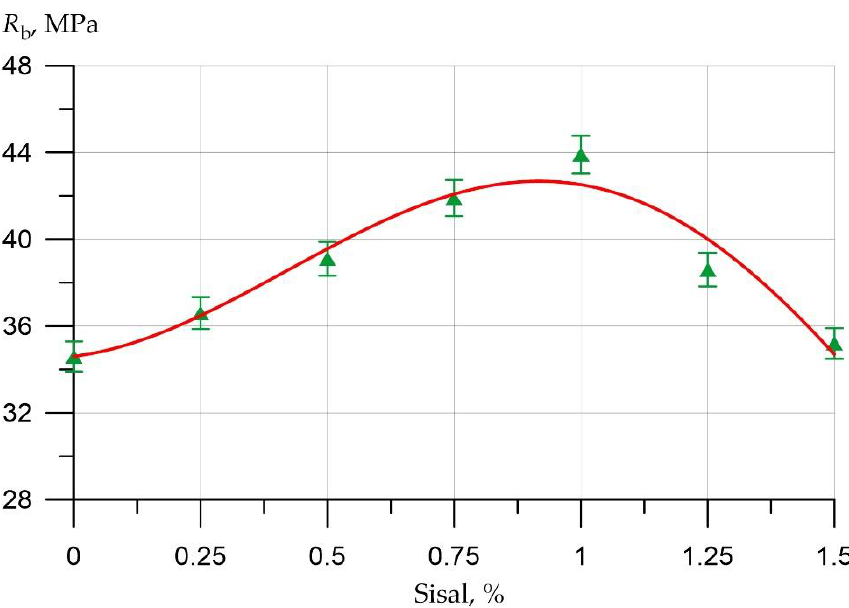
Figure 6. Results of experimental studies of the axial compressive strength R b of concrete samples in the form of prisms with various percentages of reinforcement with sisal fibers.